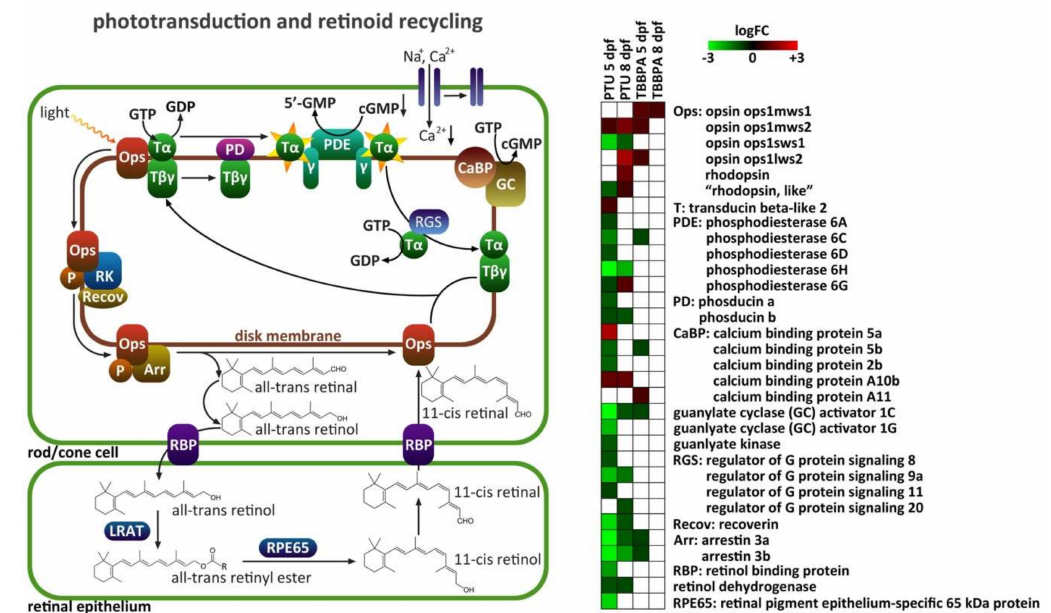
Figure 4. Overview of the effects of propylthiouracil (PTU) or tetrabromobisphenol-A (TBBPA) exposure on transcript levels of components of the phototransduction and retinoid recycling pathways. Left: detailed pathways in rod/cone cells and the retinal epithelium; Right: heatmap showing the transcript level changes of components of the pathways. LRAT: lecithin retinol acyltransferase. All other abbreviations are explained in the heatmap on the right. (Figure adapted from Houbrechts